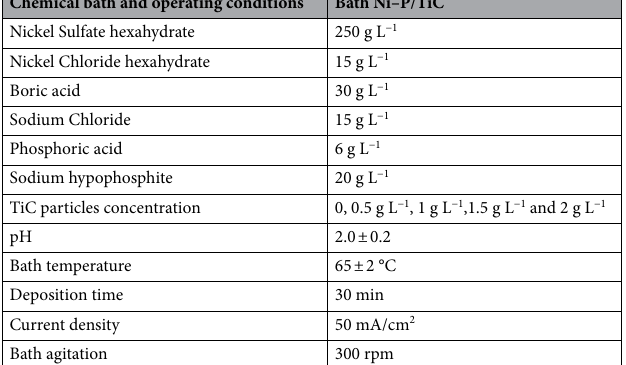
Chemical bath and operating